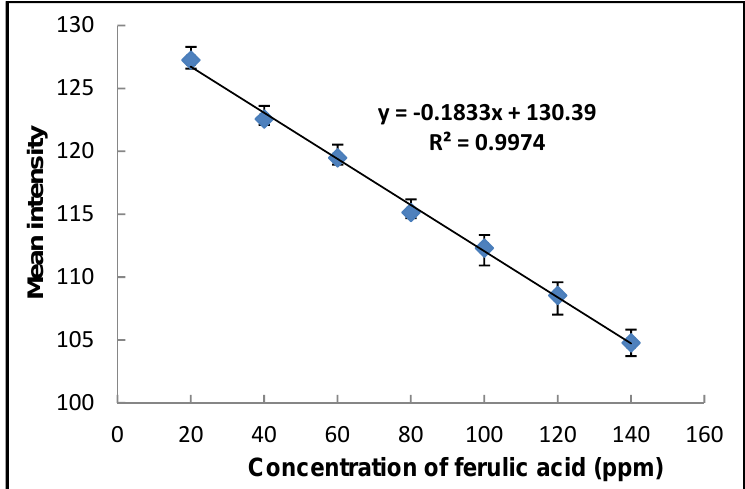
Figure 6. Calibration curve of ferulic acid using the paper-based colorimetric detection. Data shown are the mea ± 1 SD and are derived from 3 independent